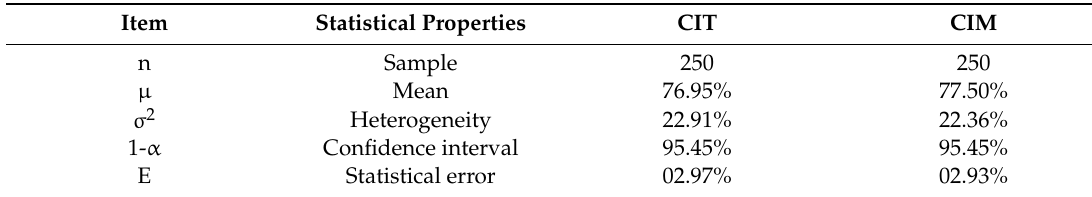
Table 9. Reliability and accuracy of the measuring instrument.